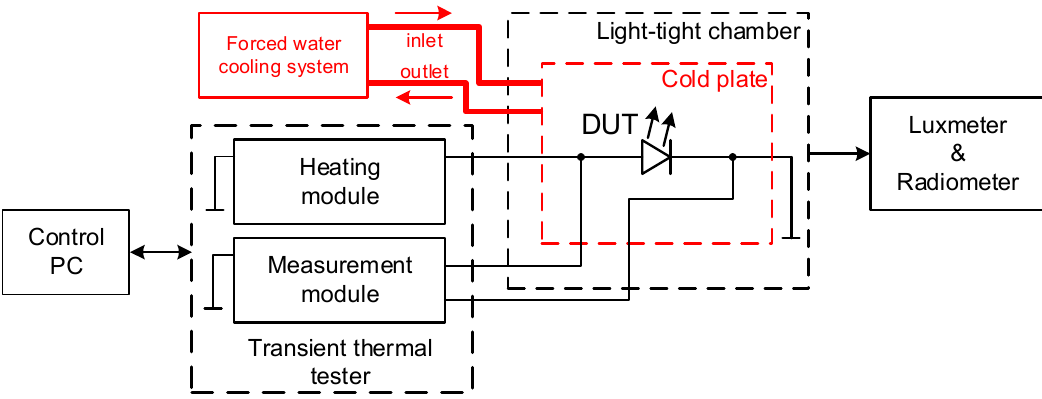
Figure 2. Block diagram of the measurement set-up.